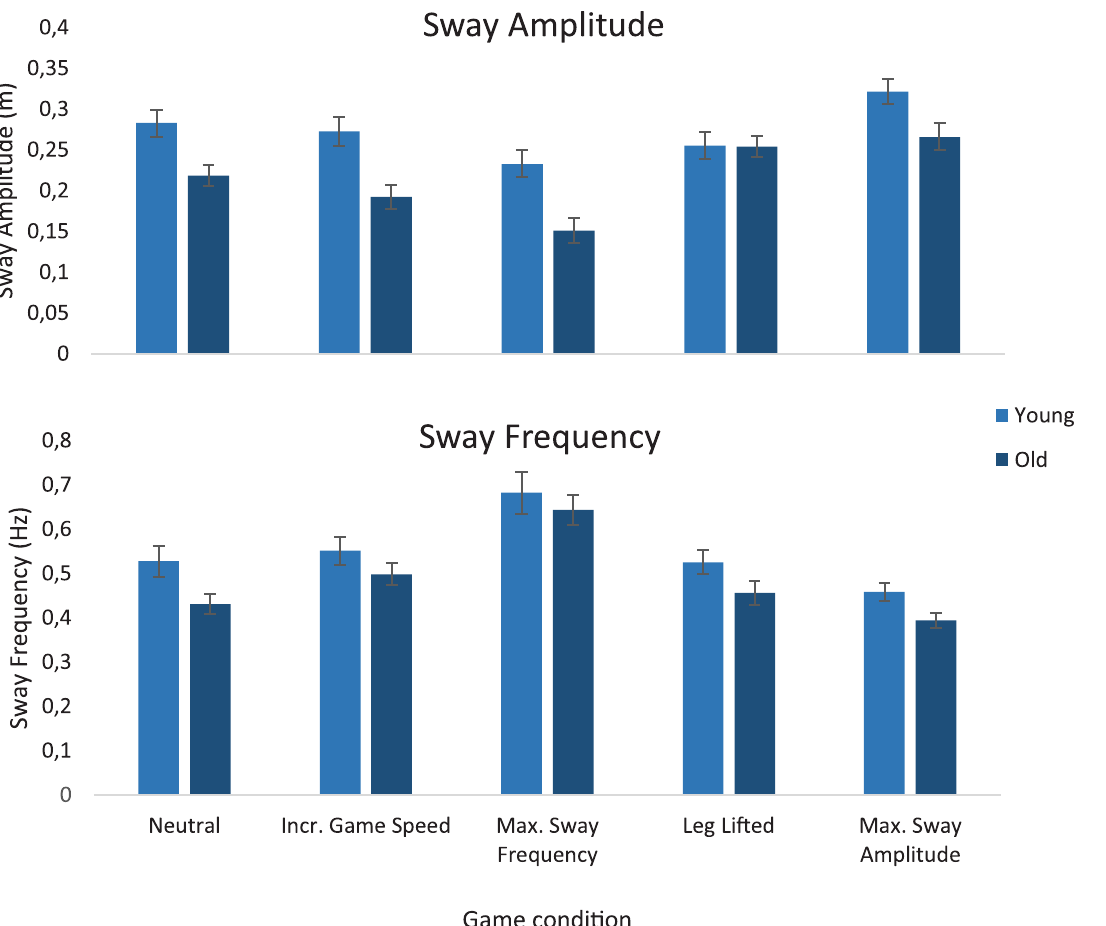
Fig 2. Sway amplitudes and frequencies under different game conditions. Sway amplitudes (top panel) and sway frequencies (lower panel) of young (light bars) and old (dark bars) adults in each game condition. Error bars indicate 1 SEM.